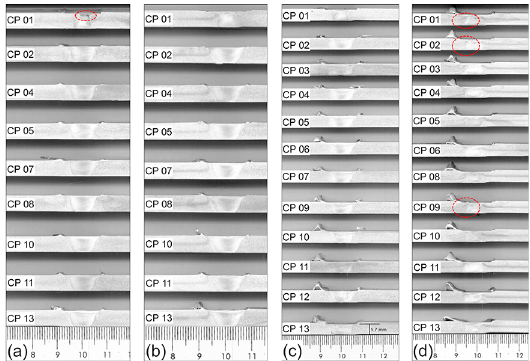
Figure 5. FSW macrostructures: (a) G1, (b) G2, (c) G3 and (d)